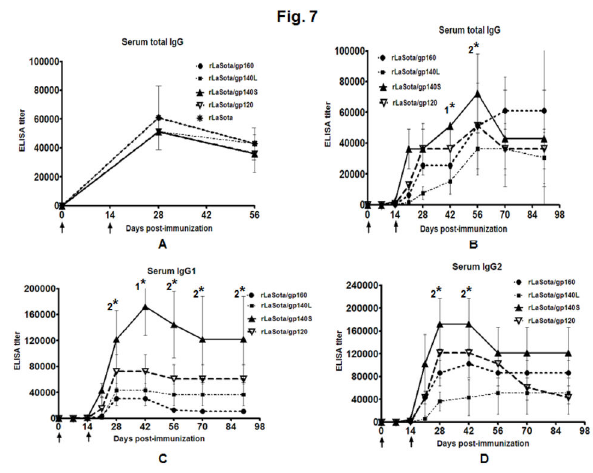
Figure 8. HIV-1 gp120-specific total IgG (panel A), IgG1 (panel B), IgG2a (panel C) and IgA (panel D) antibodies in vaginal washes collected from guinea pigs, detected by isotype-specific ELISA with purified gp120. The guinea pigs were immunized with the indicated rNDVs by the i.n. route. not detected in any animal on any day in control rLaSota